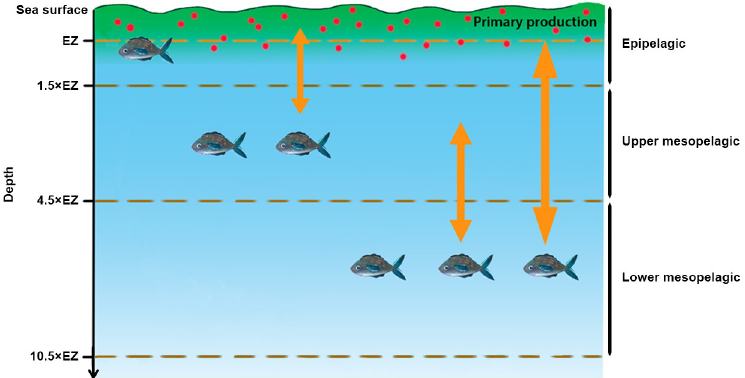
Fig 2. Vertical repartition of the functional groups of micronekton in SEAPODYM in the water column. The three depth layers, epipelagic, upper mesopelagic and lower mesopelagic layers are defined in SEAPODYM as multiples of EZ (depth of the euphotic zone set maximum at 1,000 m); fishes represent the micronekton functional groups; the red dots represent the zooplankton and the yellow arrows represent the daily vertical migrations of the functional groups between